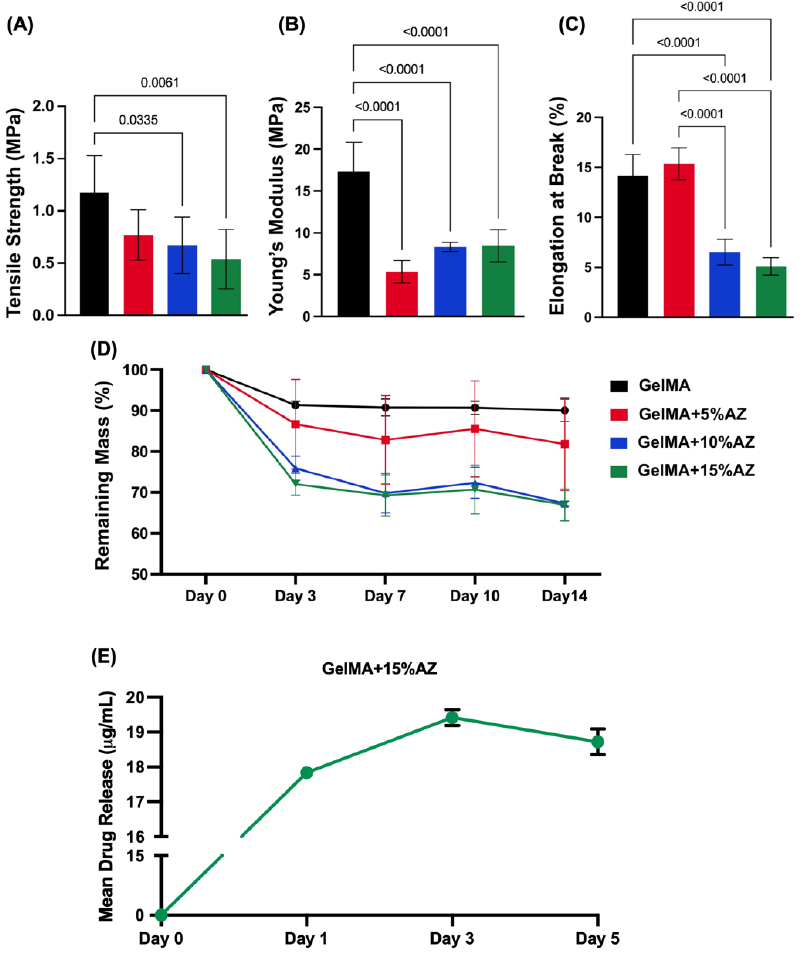
Figure 3. Mechanical analyses of the engineered GelMA-based electrospun fibers laden with 3 distinct amounts of azithromycin. ( A ) Tensile strength in MPa; ( B ) Young’s modulus in MPa; ( C ) Elongation at break in %; and ( D ) Degradation profile over 14 days in %. ( E ) Release profile of AZ from GelMA+15%AZ fibers over 5 days. Data are shown as mean and standard deviation.